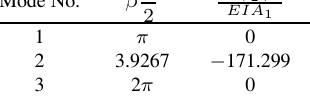
Table 2 Two-span beam with equal span lengths